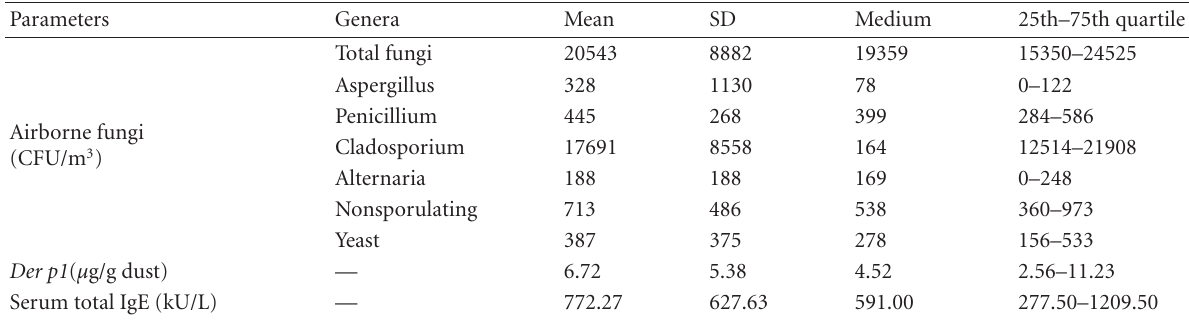
Table 1. Domestic fungal and Der p1 concentrations and the corresponding serum total IgE levels in 28 asthmatic children.